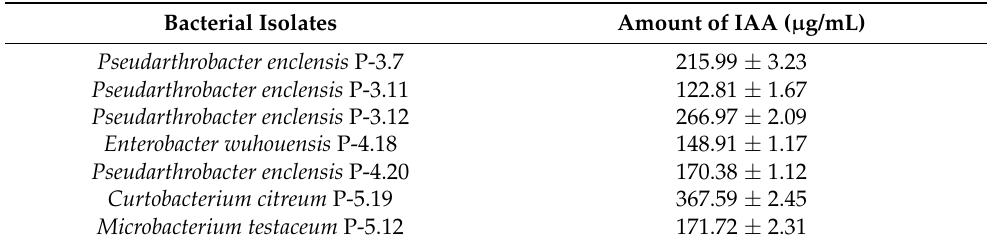
Table 2. Indole ‐ 3 ‐ acetic acid (IAA) levels in culture supernatant of selected endophytic bacterial isolates determined by HPLC analysis.